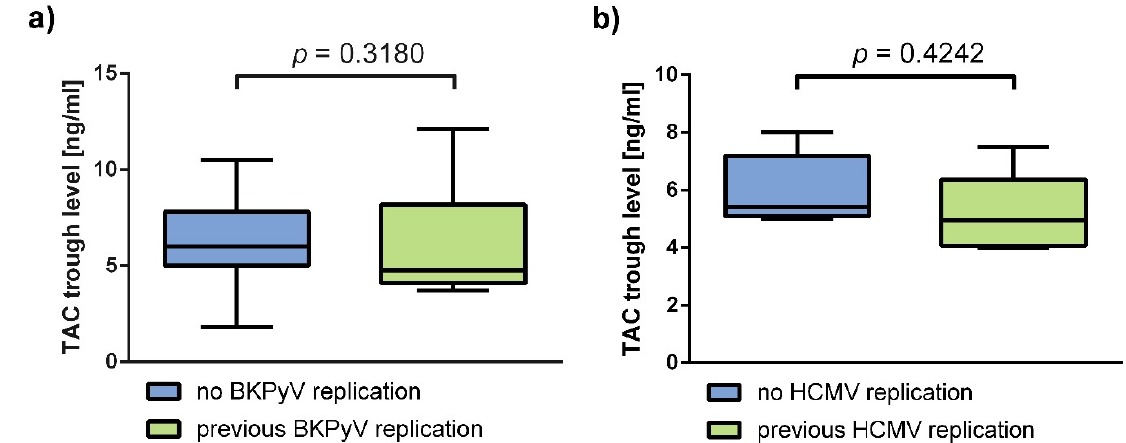
Figure 4. The compared subgroups show no significant difference in TAC trough levels. ( a ) TAC trough levels at the day of measurement were compared between patients with ( n = 16, Median = 4.75, IQR = 4.10 to 8.2) and without ( n = 23, Median = 6.00, IQR = 5.00 to 7.80) a previous occurrence of BKPyV reactivation. No significant difference in TAC trough levels was found between the two groups ( p = 0.3180). ( b ) TAC trough levels at the day of measurement were compared between HCMV high-risk renal transplant recipients with ( n = 6, Median = 4.95, IQR = 4.08 to 6.38) and without ( n = 5, Median = 5.40, IQR = 5.10 to 7.20) a history of HCMV reactivation prior to measurement. No significant difference in TAC trough levels was found between the two groups ( p = 0.4242). The bar charts show the medians with IQR of TAC trough levels at the day of the measurement. Mann–Whitney-U-Test was used to determine significance.